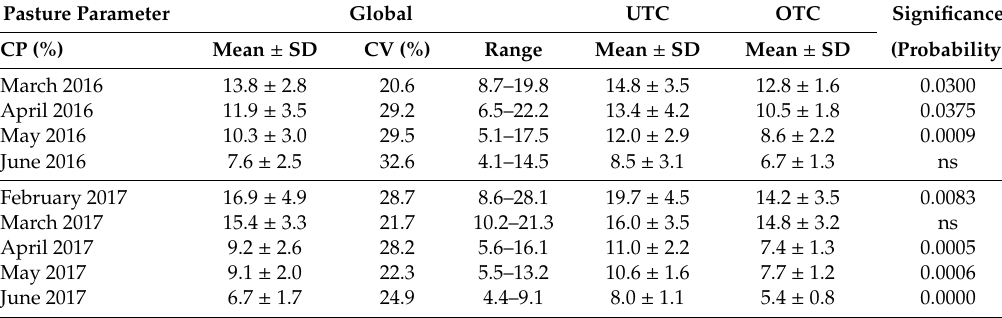
Table 3. Pasture quality (CP, crude protein, %; and NDF, neutral detergent fiber, %) of the studied field for each sampling date: Global (all sampling points), UTC (12 sampling points under tree canopy) and OTC (12 sampling points outside tree